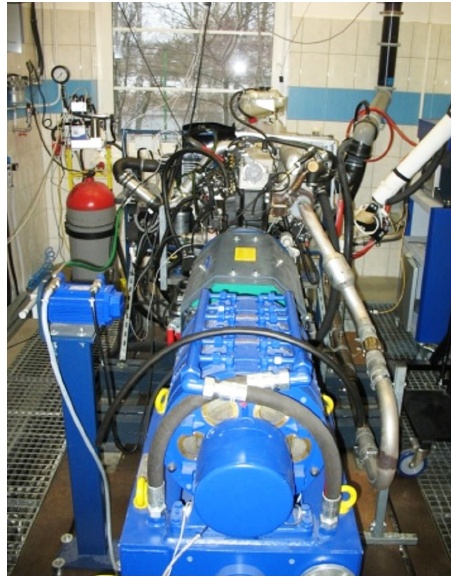
Fig. 2. The test stand with an ADCR engine installed at the engine test